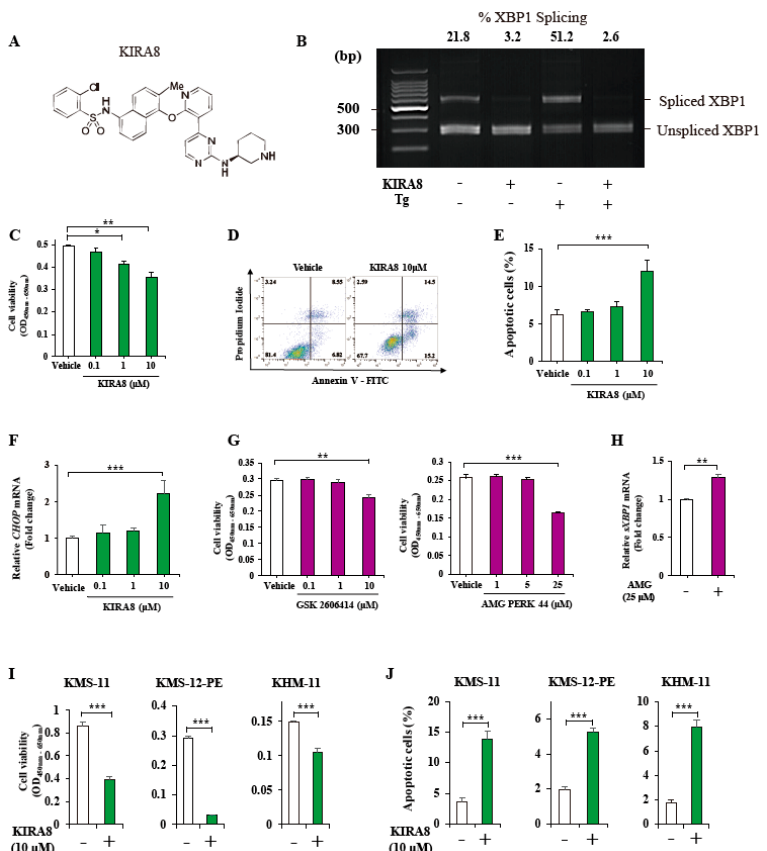
Figure 2. E ff ects of kinase-inhibiting RNase attenuator 8 (KIRA8) and protein kinase R-like endoplasmic reticulum kinase (PERK) inhibitors on human myeloma cells. ( A ) The structure of KIRA8 ( B ) Pst I-digested X-box Binding Protein 1 (XBP1) cDNA amplicons from IM-9 cells treated for 24 h (h) with vehicle (dimethyl sulfoxide, DMSO) or 10 µ M of KIRA8 and 500 nM of thapsigargin (Tg). Top, the intensity ratios of the spliced form to the total XBP1 . ( C – E ) IM-9 cells were treated with vehicle (DMSO) or KIRA8 with the indicated concentrations for 24 h. ( C ) The cell viability was assessed using the cell counting kit-8 (CCK-8) assay. ( D , E ) Apoptosis was assessed using FACS analysis of annexin V / propidium iodide (PI)–stained myeloma cells treated with vehicle or KIRA8 for 24 h. Annexin V-positive / PI-negative cells are regarded as cells in apoptosis. Representative FACS plots show annexin V / PI-stained cells ( D ) and the % apoptotic cells ( E ). ( F ) Quantitative RT-PCR of the relative CHOP mRNAs from IM-9 cells treated with vehicle (DMSO) or KIRA8 for 24 h. ( G ) The cell viability in IM-9 cells treated with GSK 2606414 or AMG for 24 h. ( H ) Quantitative RT-PCR of the relative sXBP1 mRNA levels from IM-9 cells treated with vehicle (DMSO) or 25 µ M of AMG for 24 h. ( I , J ) The cell viability ( I ) and apoptosis ( J ) assay in three di ff erent human myeloma cells—KMS-11, KMS-12-PE, and KHM-11—treated with vehicle (DMSO) or 10 µ M of KIRA8 for 24 h. The data shown are the mean ± SEM. For all experiments, three independent biological samples were used. *, p < 0.05; **, p < 0.01; ***, p <